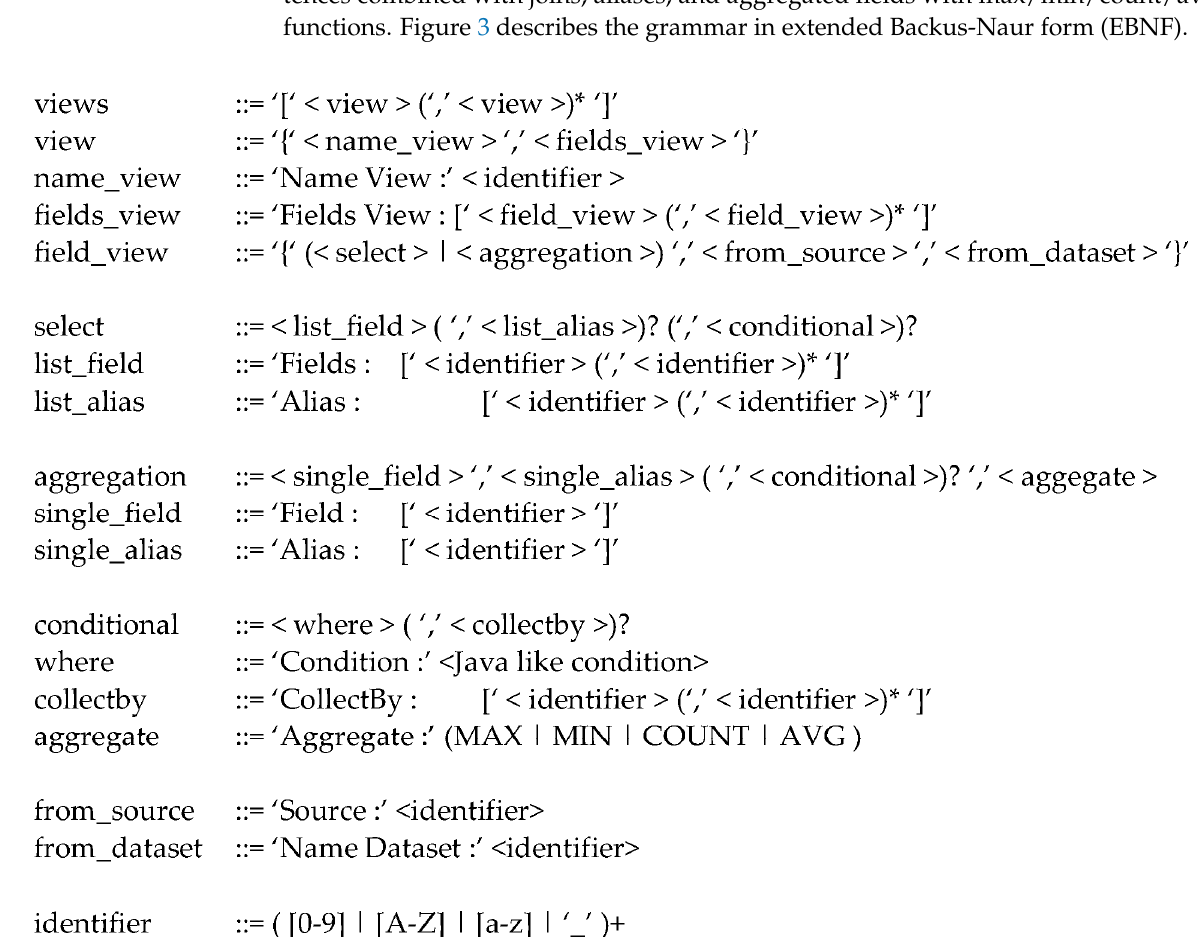
Figure 3. Extended Backus-Naur Form (EBNF) for the query language for the ETL process. Multiple views can be defined in the same file. A single view name_view includes different fields field_view that can gather fields from different sources from_source and datasets from_dataset. As aforesaid, a dataset can be queried in different ways.